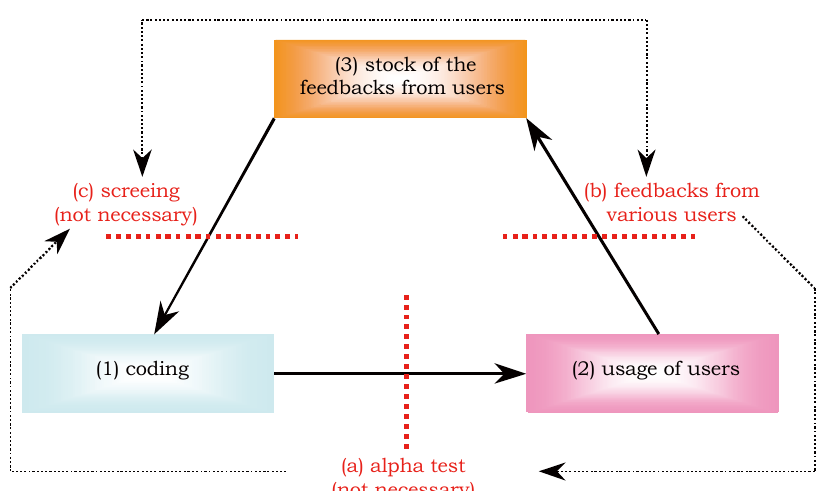
Figure 1. Development cycle of Hidemaru